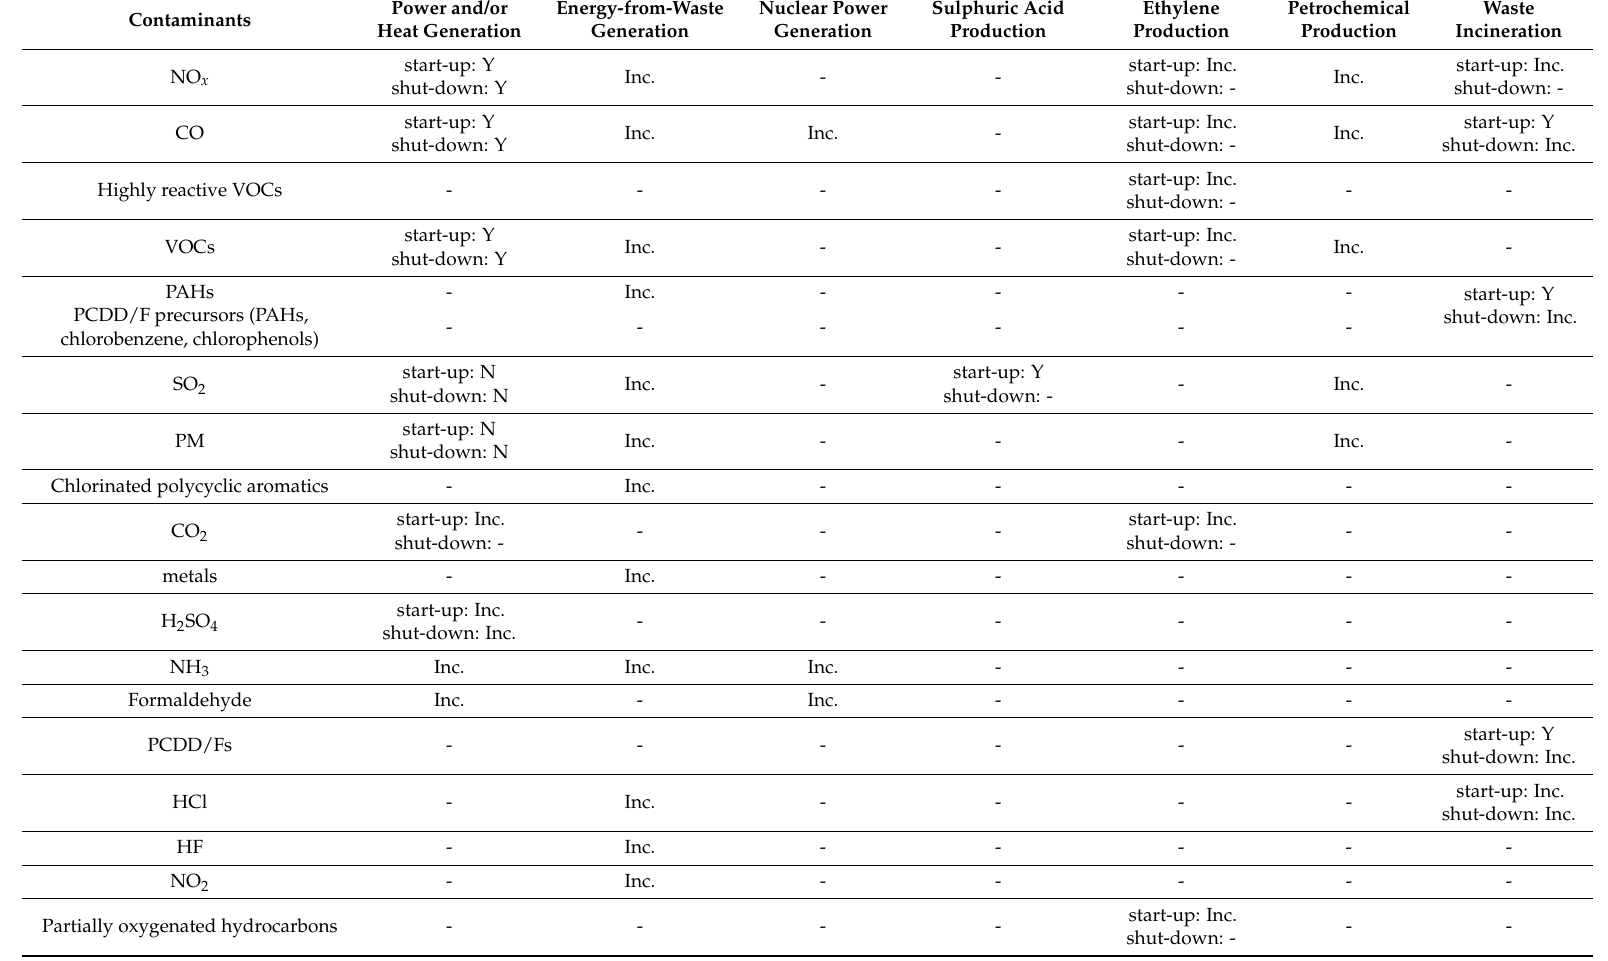
Table 6. Summary of when emissions from start-up and shut-down operations should be assessed for different industries and contaminants, based on aforementioned trends observed from case studies. Legend: must assess emissions (Y); may not need to assess emissions (N); contaminant not studied (-); and inconclusive, i.e., further investigation necessary to develop a trend